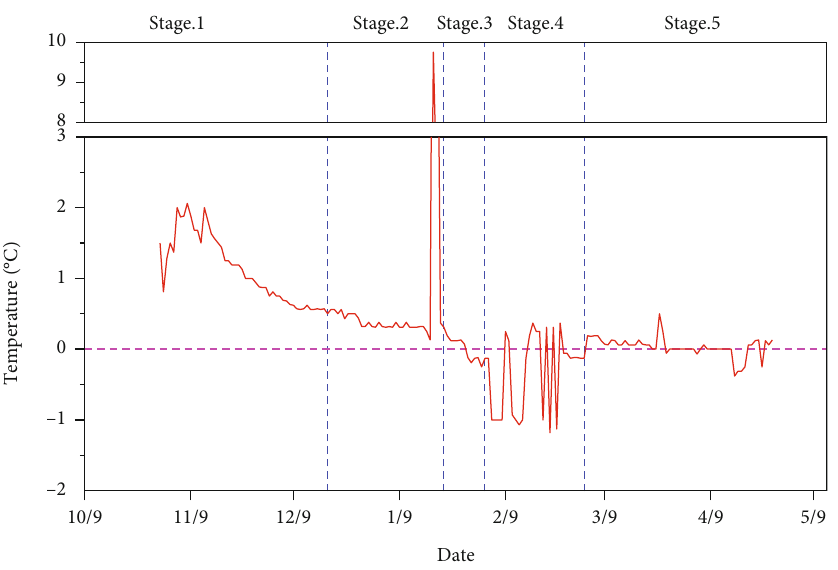
Figure 6: The temperature di ff erence of main